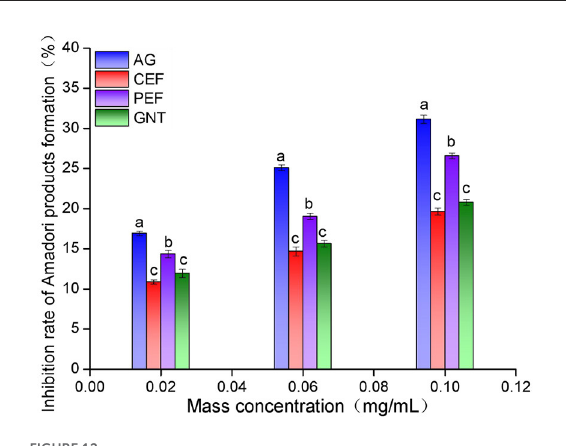
FIGURE12 Amadori products early inhibition rate of CEF, PEF, and GNT at different concentrations. Different lowercase letters represents significant differences within each group at the same concentration ( p < 0.05).